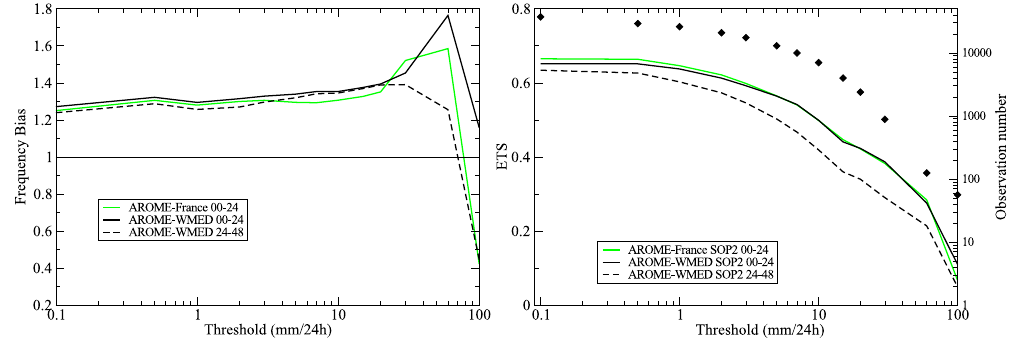
Figure 17. Frequency bias (left-hand side) and equitable thread score (ETS; right-hand side) for the 0–24h accumulated precipitation for AROME-France (green line) and AROME-WMED (black line) and for the 24–48h accumulated precipitation for AROME-WMED (dashed black line) for the SOP2 period from 01 February to 15 March 2013. Logarithm scale on x axis. Diamonds represent the number of observations used for the comparison (logarithm scale).